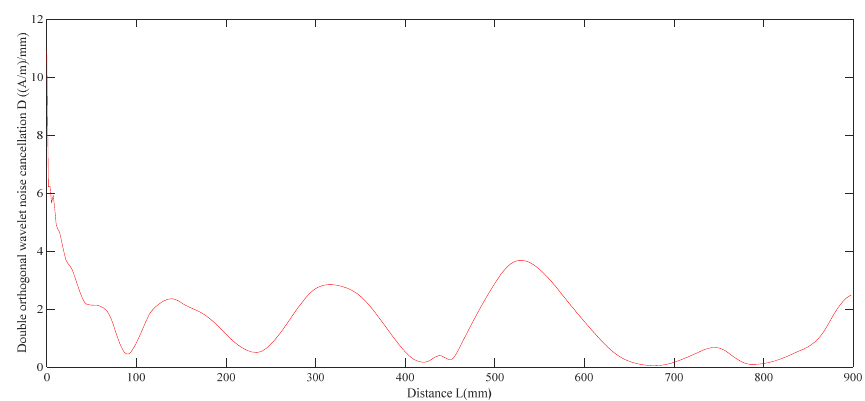
Figure 14. Double orthogonal wavelet noise cancellation.